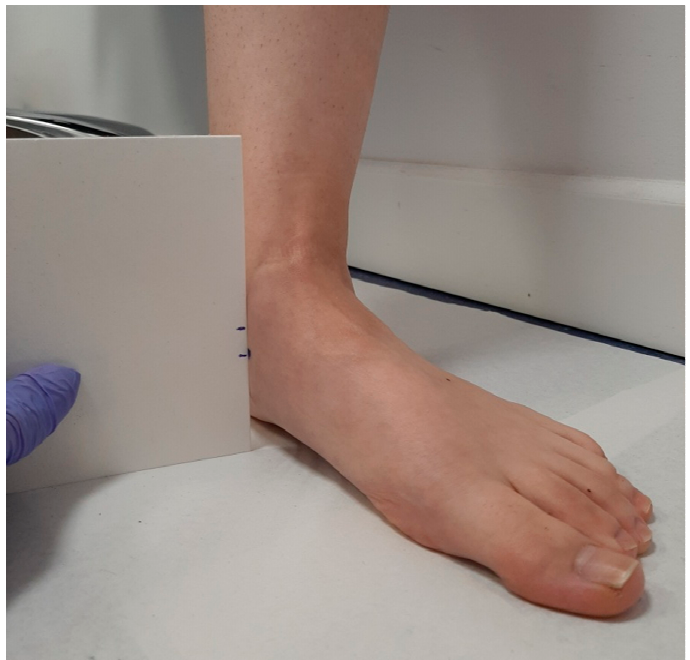
Figure 3. Measurement of the height point marked in the most prominent aspect of the medial tuberosity of the navicular bone with a relaxed position of the foot.